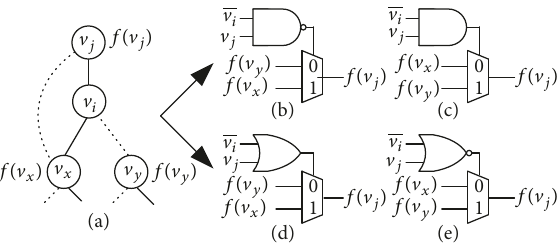
Figure 3: One case of Theorem 3 and relative feature structures. (a) One case of BDD subgraph, (b) NAND structure, (c) AND structure, (d) OR structure, and (e) NOR structure.